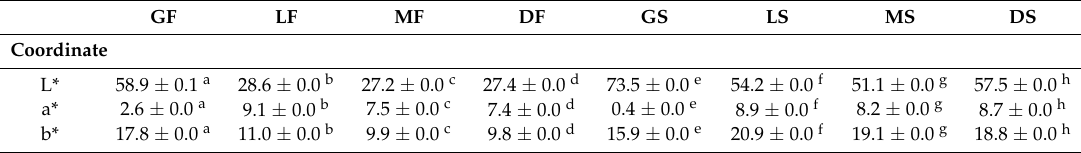
Table 1. Colorimetric coordinates (L* a* b*) of the dry extracts of Robusta coffee. GF